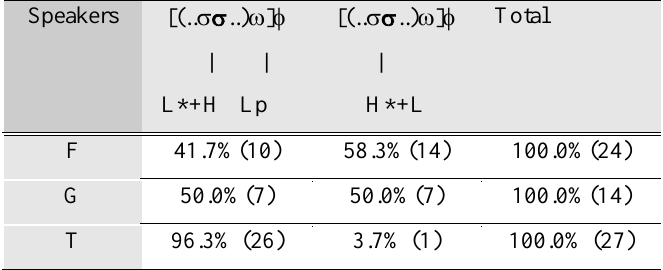
Table V. Tonal events associated with the initial part of the sentence contour in the context of narrow-focus on the subject, when the  that contains the subject is non-branching and formed of up to three syllables (  ) (1 pretonic, 1 stressed and 1 posttonic  s) and in which the subject forms a non-branching  .